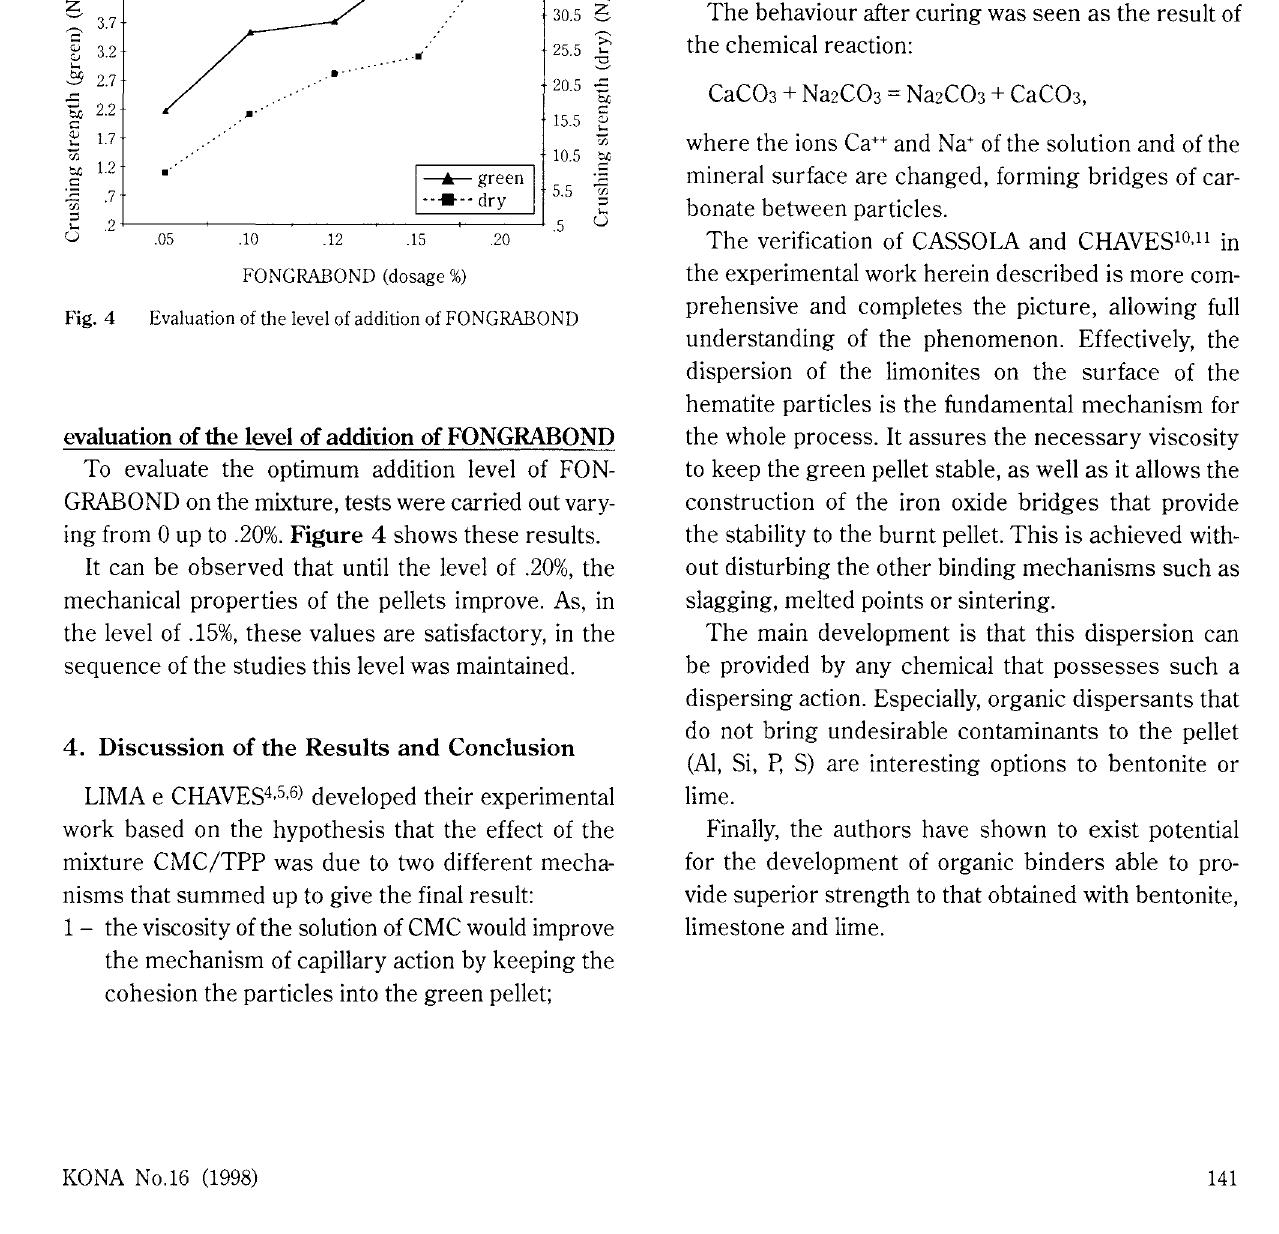
Evaluation of the action of the other binders